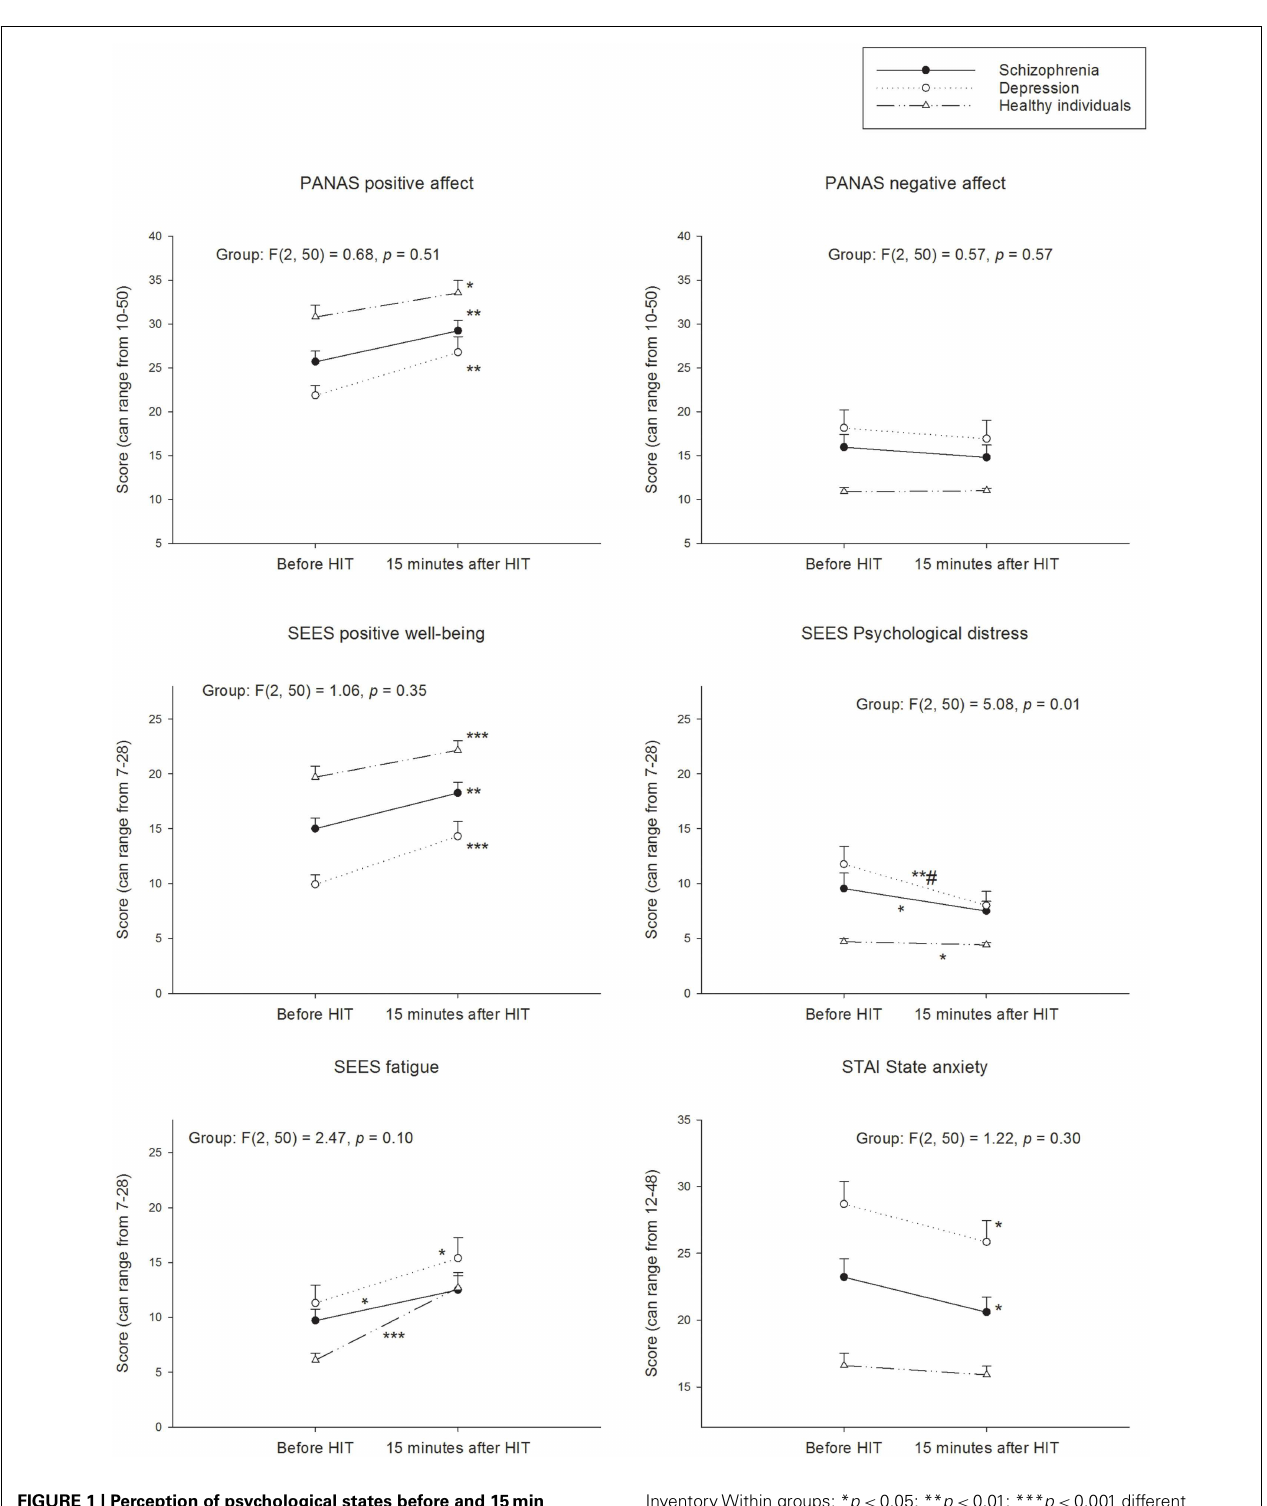
FIGURE 1 | Perception of psychological states before and 15min after HIT . PANAS, Positive and Negative Affect Schedule; SEES, Subjective Exercise Experiences Scale; STAI, State-Trait Anxiety